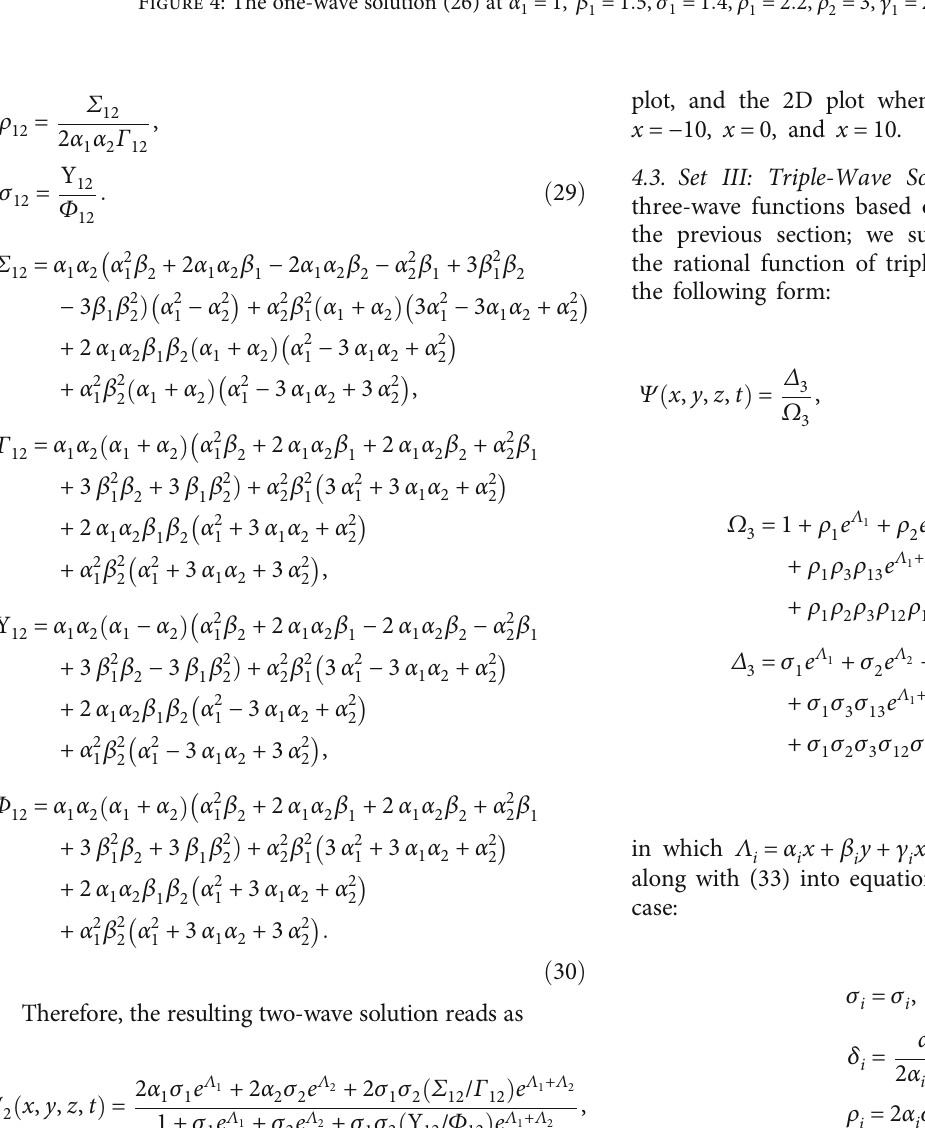
Figure 4: The one-wave solution (26) at α